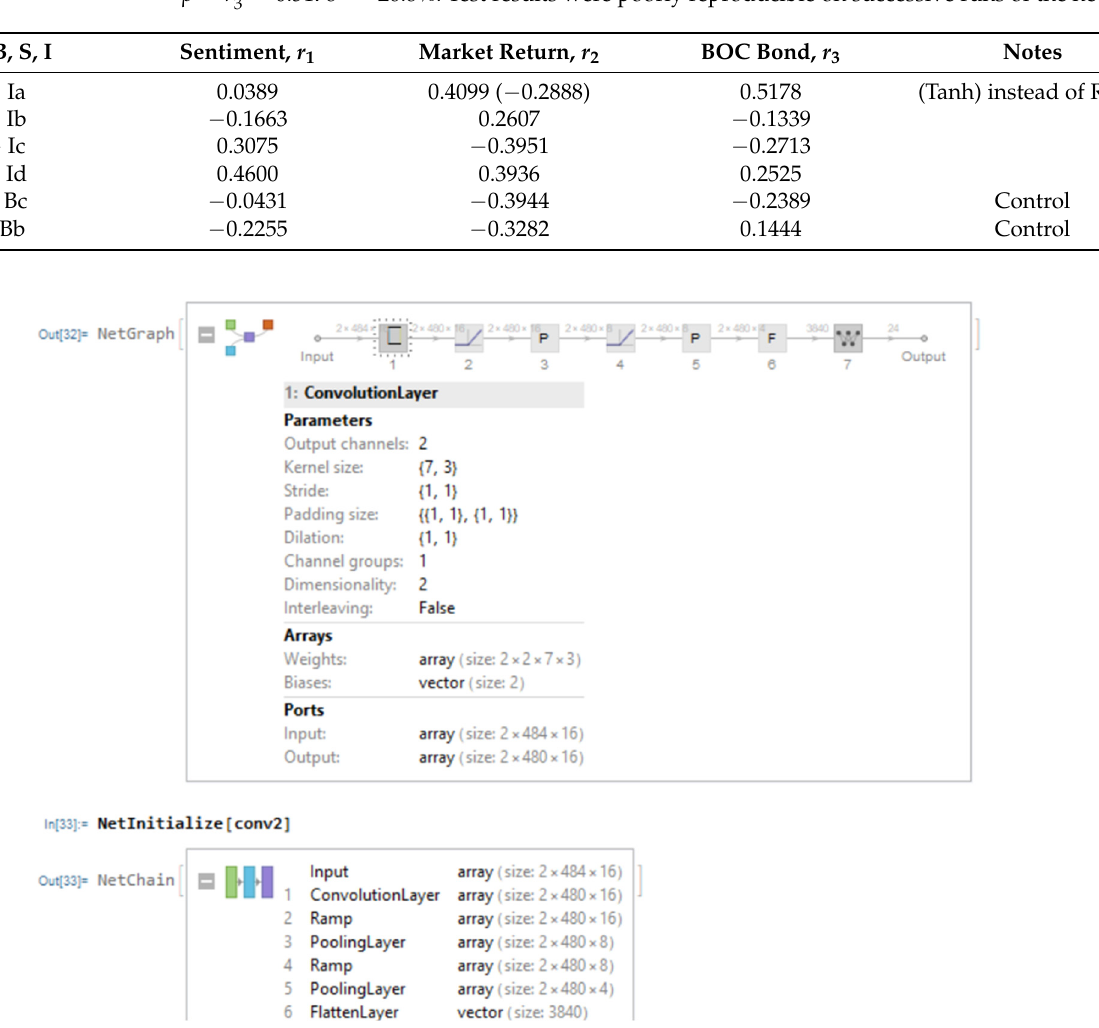
Table A1. Select runs of a 10-layer neural network for the backward prediction of monthly indexes from traders’ activity. Capital letters B, S, and I mean “Buy”, “Sell”, and “Imbalance” samples of residuals. Letters from a-d refer to a particular trader. An arrow designates training vs. prediction tapes. The symbols r 1-3 refer to the correlation coefficients of the neural network predictor and the actual indexes. The explanatory power of the predictions can be inferred from the squares of the correlation coefficient. For instance, if we treat broker “b” as informed, trader “a” could have pre- dicted bond yield for the next month from their imbalances with an explanatory power 𝜌 = 𝑟 (cid:2871)(cid:2870) = 0.5178 (cid:2870) ≈ 26.8%. Test results were poorly reproducible on successive runs of the network.